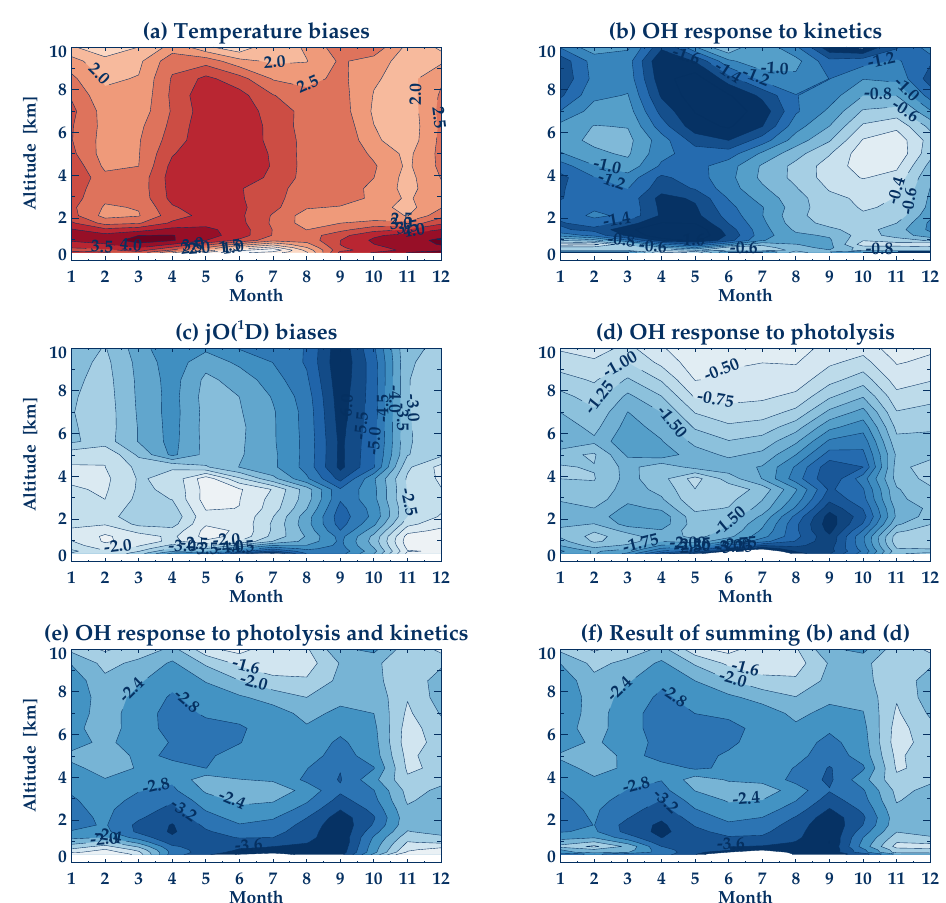
Figure 8. Multi-annual and monthly-mean OH responses to temperature biases between observations (radiosonde and NCEP/NCAR tem- perature) and the reference simulation. (a) Difference in radiosonde and NCEP/NCAR temperature (K) relative to the reference temperature. (b) OH difference (%) relative to the reference simulation accounting only for the kinetics effects of temperature differences (e.g. with j unchanged). (c) Difference in j (%) relative to the reference simulation. (d) OH difference (%) relative to the reference simulation ac- O 1 D counting only for j differences (i.e. with temperature unchanged). (e) OH differences relative to the reference simulation considering the O 1 D combined kinetics and photolysis effects. (f) Sum of (b) and (d)